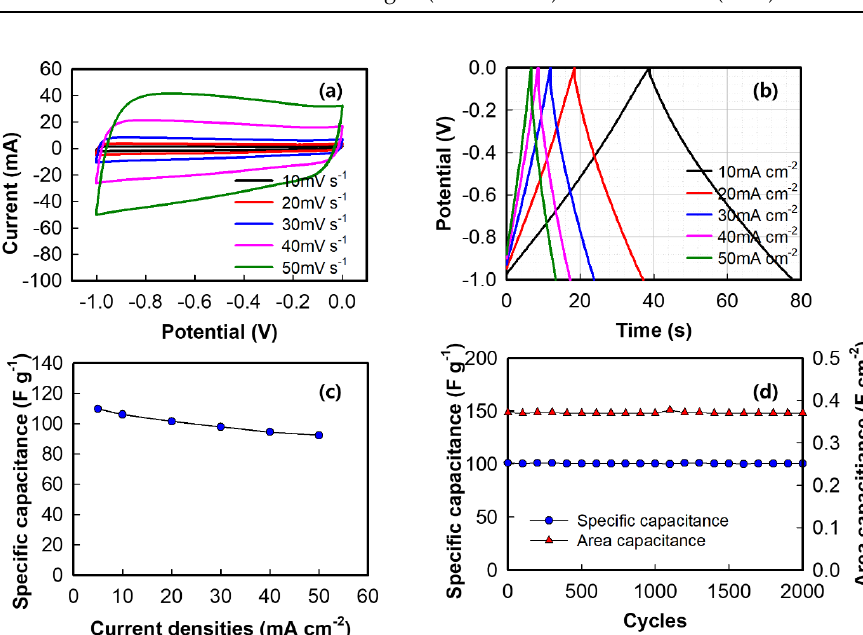
and symmetrical, indicating the good reversibility. The SCs of the AC electrode are calcu- lated based on the GCD curves using Equation (1). An SC is 109.8 F g −1 (0.4 F cm −2 ) appears at 5 mA cm −2 , which declines to 101.5 F g −1 (0.34 F cm −2 ) at 50 mA cm −2 . The AC electrode maintains 99.5% of its initial capacitance after 2000 cycles as shown in Figure 6d.